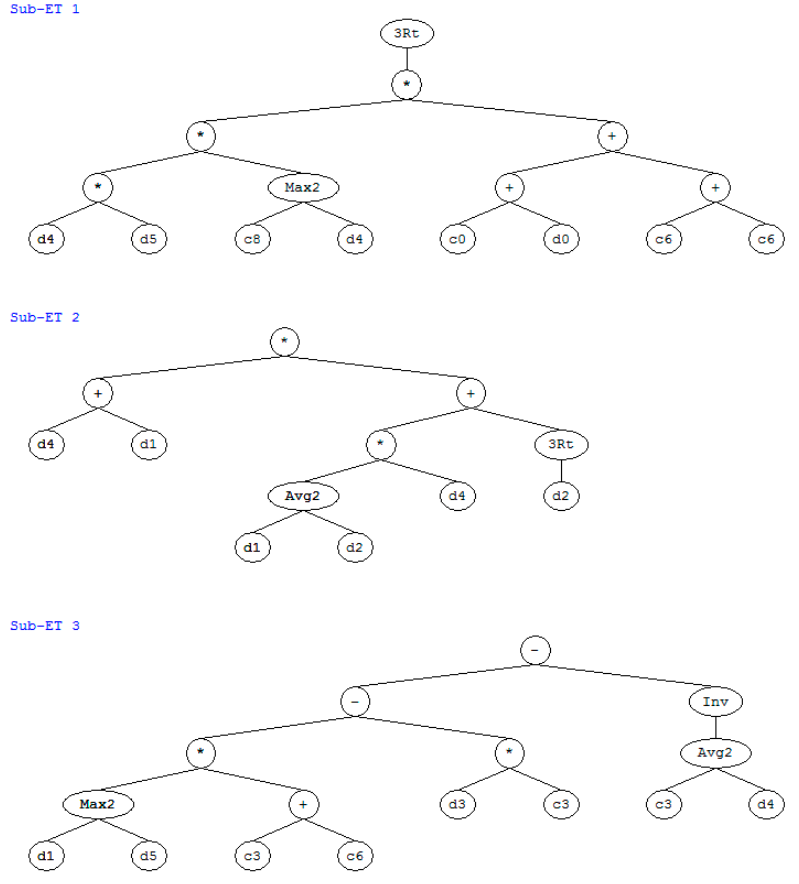
Figure 4. Expression tree for slump.